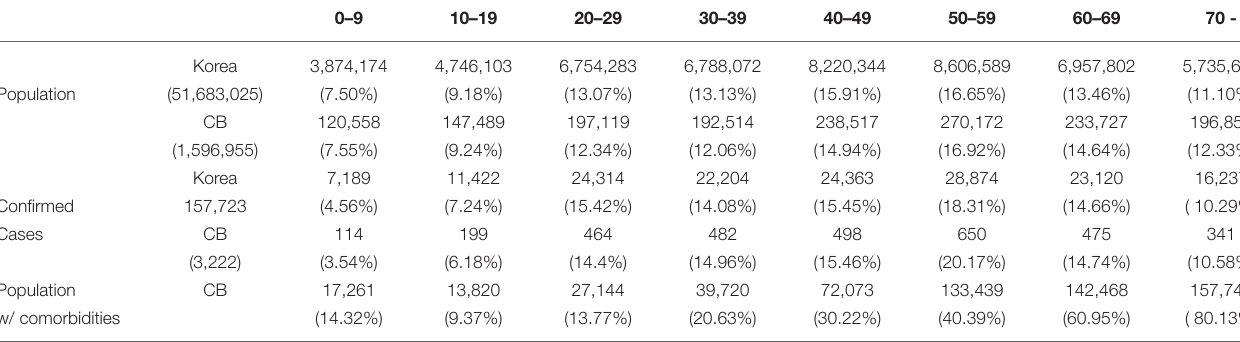
TABLE 1 | Age-specific population size and number of confirmed COVID-19 cases are compared for CB and South